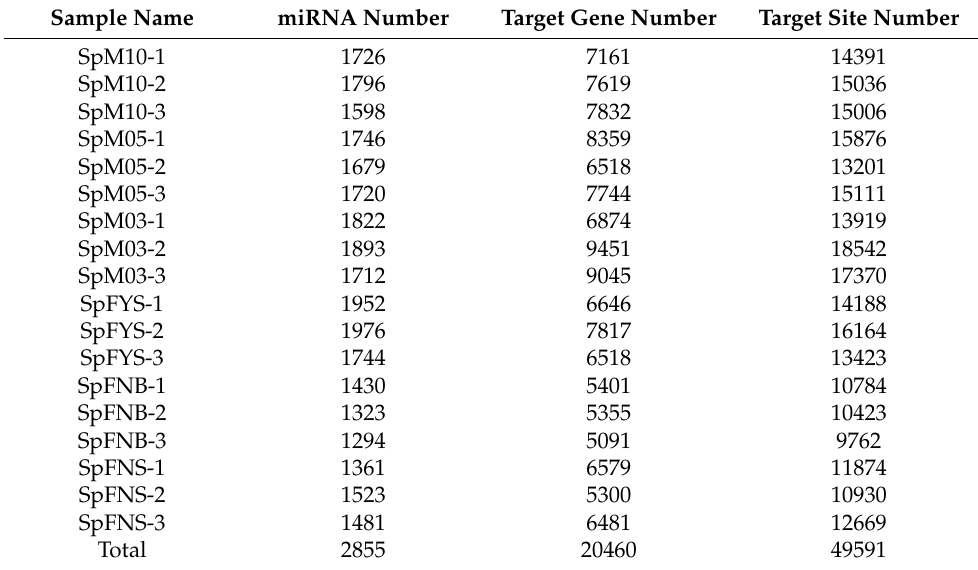
Table 3. Statistics of target gene prediction of all